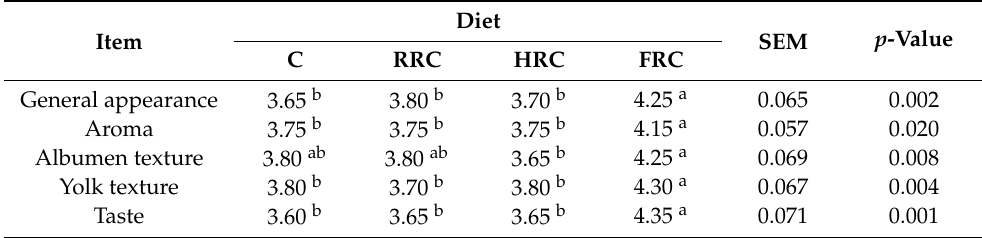
Table 7. Average intensity values of egg sensory attributes 1